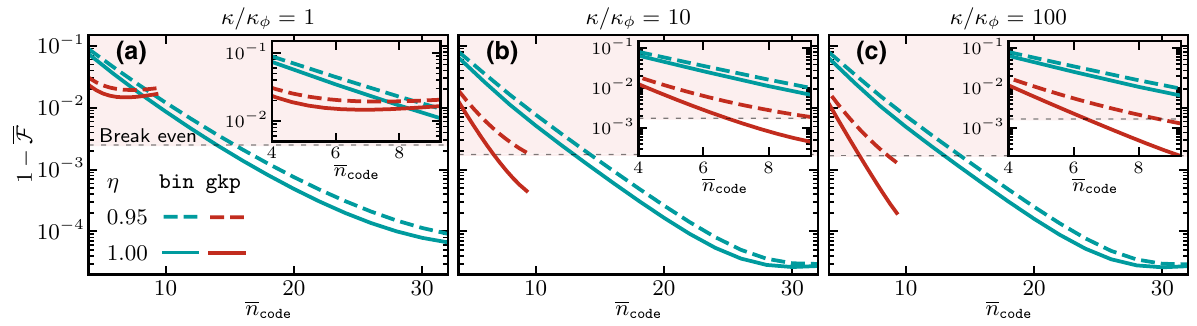
FIG. 11. Performance of gkp and bin codes subject to the same initial noise channel described by Eq. (16) with κτ = 5 × 10 − 3 and different ratios κ/κ φ ∈ { 1, 10, 100 } in panels (a)–(c). Solid lines show results for the respective telecorrection cir- cuits (Figs. 2 and 9) with unit-efficiency measurements, while dashed lines show the results obtained for a measurement with efficiency η = 0.95. We consider RSB codes of orders N = 4 and M = 1 for the data and ancilla qubits in Fig. 2, respectively, and n data = n anci . The logical X measurements are both realized as AHD measurements. For the gkp code, we set δ code = δ anci . ≈ 10 dB) for the Fock space simulation due to numerical constraints. Insets show enlarged We are limited to n gkp < 10 ( (cid:17) ( dB ) gkp views of this region. Error correction is beneficial whenever the infidelity falls below the dashed line that indicates the break-even point. The results for bin codes are defined only for discrete values of n code and we show continuous lines only for improved